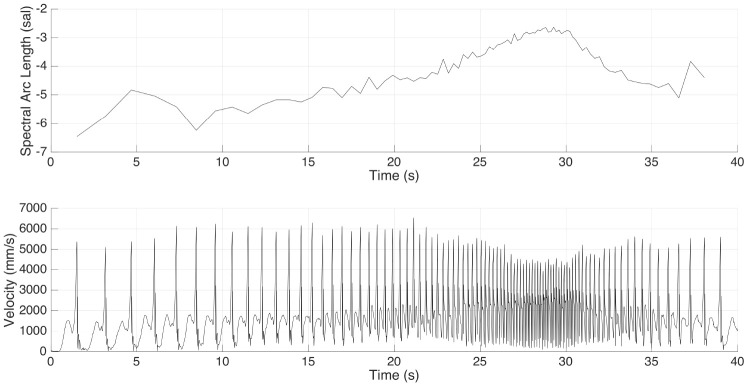
Top: Drum stick spectral arc length metric evolution from participant D3 during the single roll task. Bottom: Drum stick velocity profile from participant D3 during the single roll task.